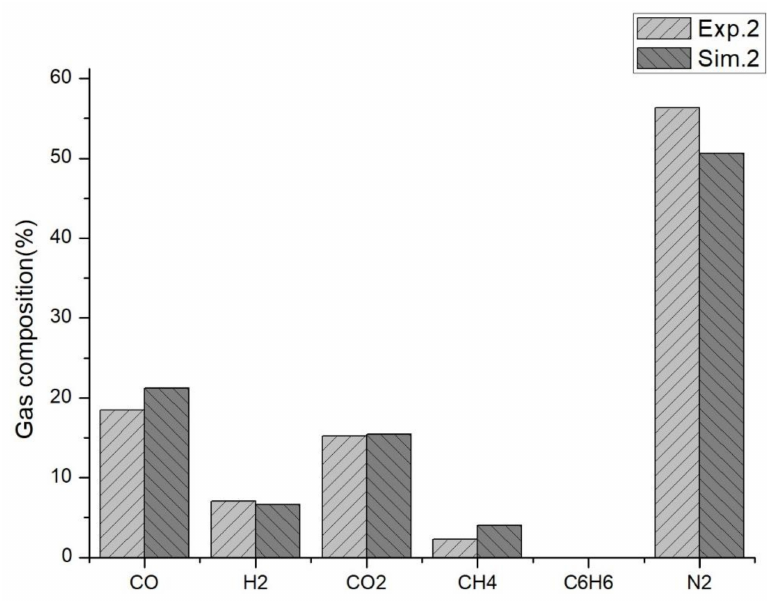
Figure 4. Syngas distribution comparison in case 2 (Air: 5 Nm 3 / h, Oxygen: 1.2 Nm 3 / h).